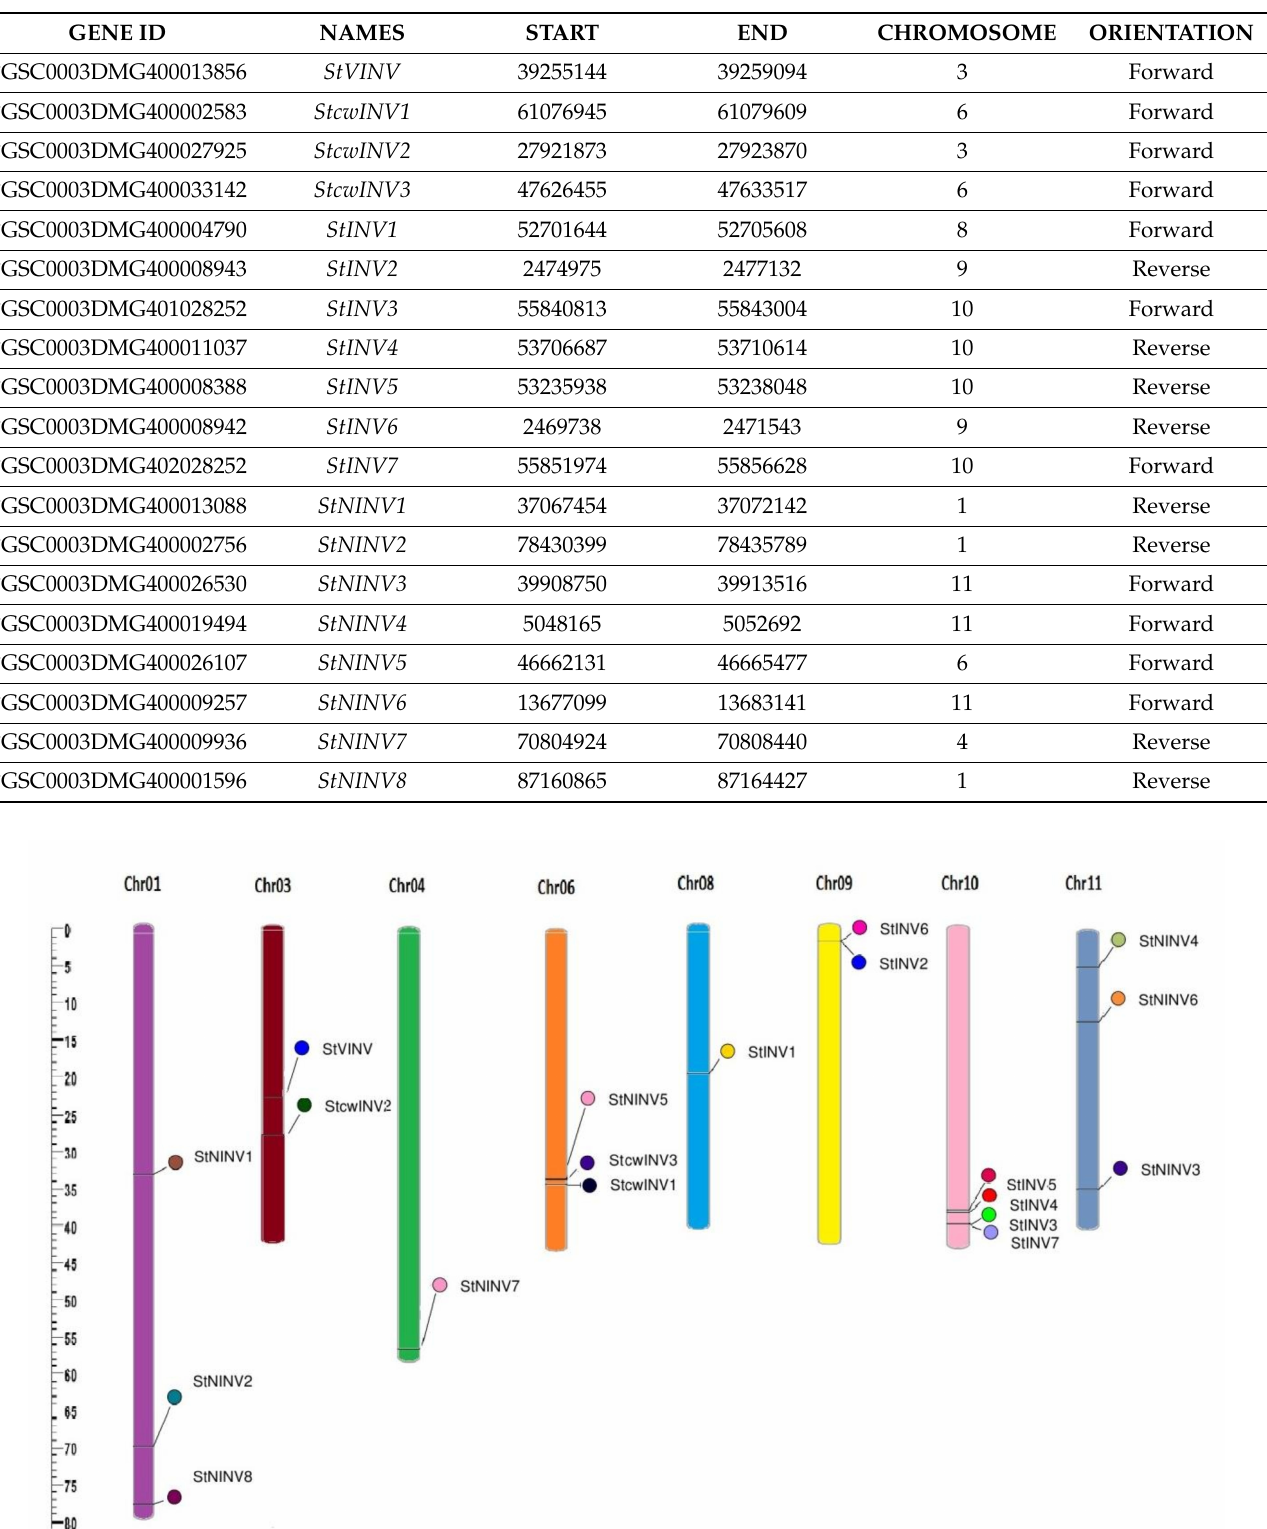
Table 1. Invertase family member genes.